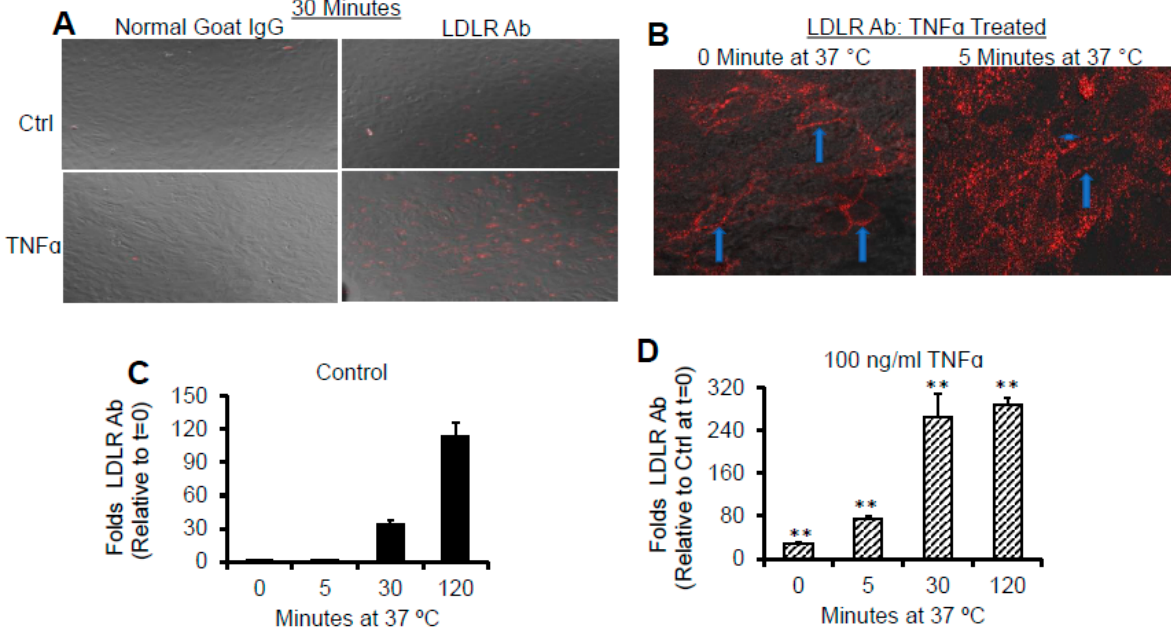
Figure 9. TNF α promotes rapid association of LDLR with it antibody. pHAECs in serum medium were pre-treated with 0 (Ctrl) or 100 ng/mL TNF α (TNF α ) for 24 h. Subsequently, in the continued presence of TNF α , the media were replaced with 5 µ g/mL control normal goat IgG or LDLR antibody (LDLR Ab) for 0, 5, 30, or 120 min at 37 ◦ C. The surface-accessible LDLR was then determined as detailed under Experimental Procedures. ( A ) 20 × objective magnification of LDLR detected after 30 min. ( B ) 40 × confocal detection of LDLR in TNF α -treated pHAECs at 0 and 5 min. The arrows show the membrane distribution of the LDLR in focus, while the arrowhead shows internalized LDLR. ( C ) Surface-accessible LDLR as a function of time under control condition. ( D ) As C, in the presence of TNF α . n = 4. **, p < 0.01 relative to control at the same time.